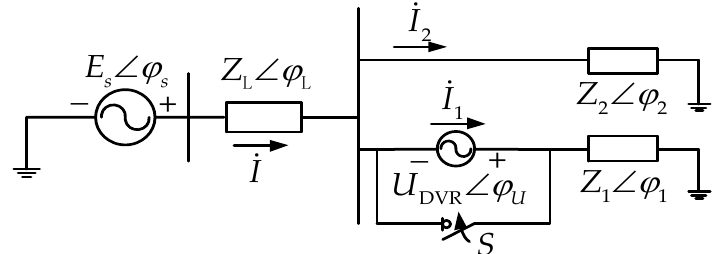
Figure 2. Equivalent circuit of DVR-sensitive load structures with the adjacent loads; E S ∠ ϕ s is an infinite system source, regarded as a constant; U DVR ∠ ϕ U is the compensation voltage of the DVR; Z L ∠ ϕ L is the line impedance; Z 1 ∠ ϕ 1 is the sensitive load impedance; Z 2 ∠ ϕ 2 is the adjacent load impedance; I I are normal running currents of the sensitive load and the adjacent load respectively before voltage sag; and, I is the current provided from the source to the loads in normal operation.